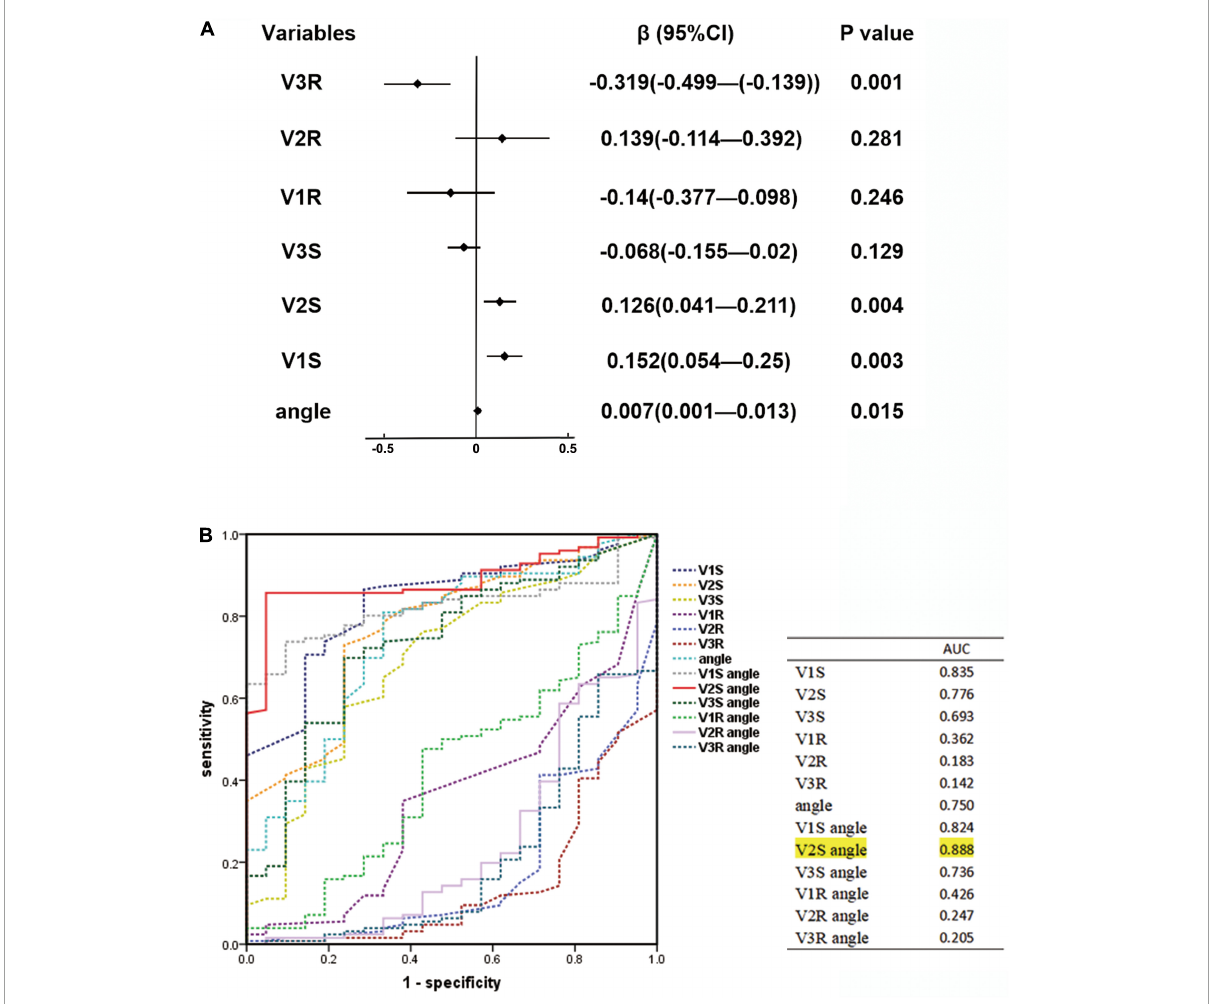
FIGURE2 (A) Linear regression analysis for ECG characteristics and angle. The regression coefficient β and 95% CI of each independent variable are shown above. The final multiple linear regression model was statistically significant ( F = 14.278, P < 0.001), and 38.9% of the variation in the dependent variable ECG algorithm could be explained by V1S, V2S, V3R, and angle (adjusted R 2 = 0.389). (B) Receiver operating characteristic (ROC) curve analysis for anatomic prediction of RVOT origin was also performed. The area under the curve (AUC) of the V2S angle was 0.888, which was the highest among all